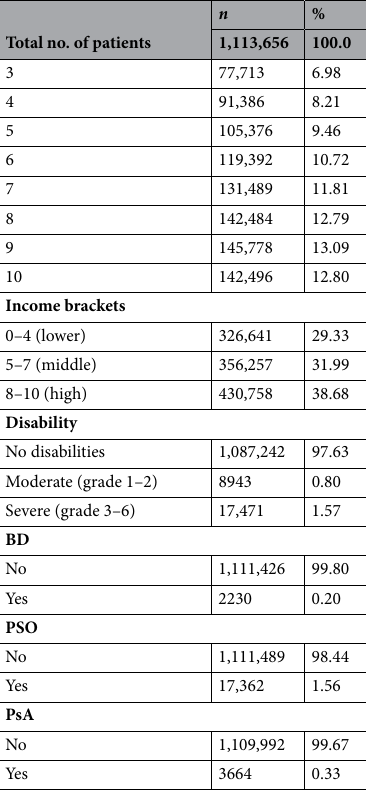
Table 2. Baseline characteristics. BD, Behçet disease; PSO, psoriasis; PsA, psoriatic arthritis.